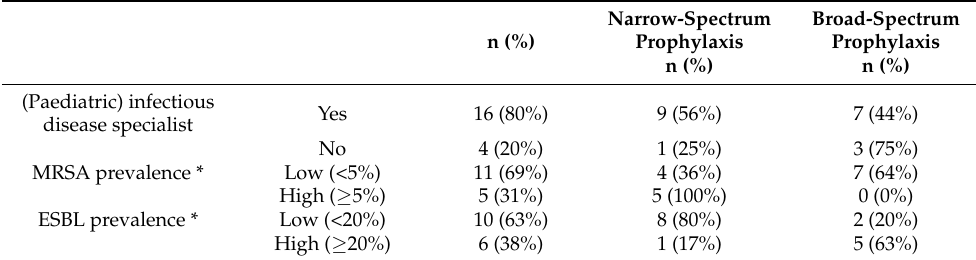
Table 3. Association of prophylaxis spectrum with prevalence of multidrug resistance and availability of infectious disease